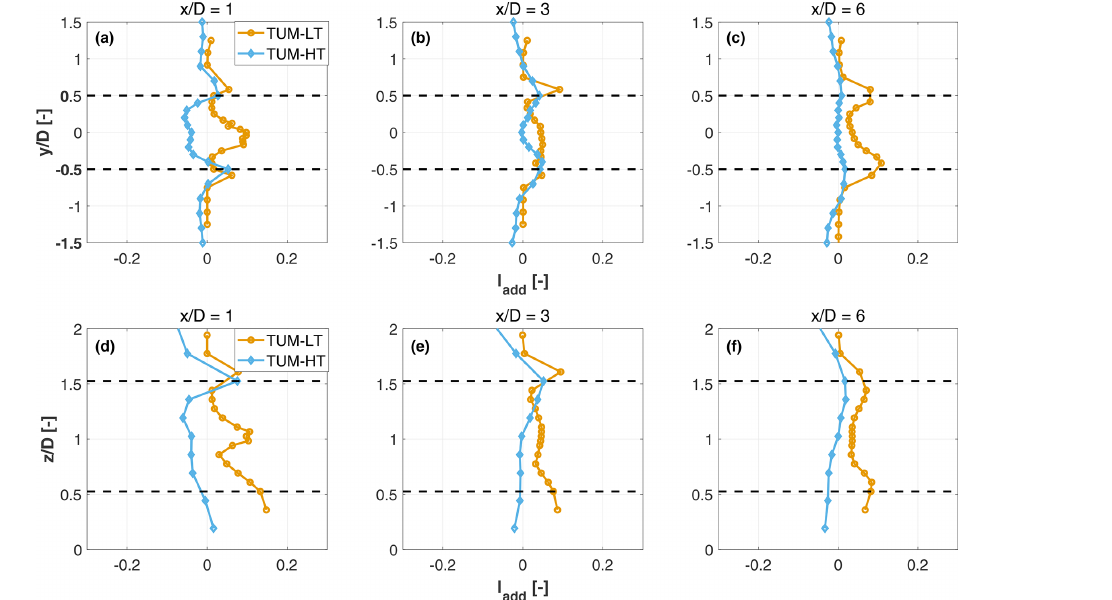
Figure 18. Horizontal (a–c) and vertical (d–f) profiles of added TI at several downstream distances and different inflow conditions. Black dashed lines indicate the rotor